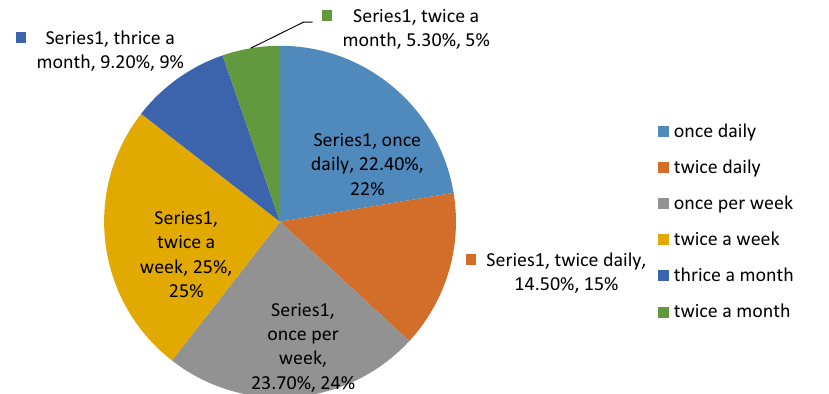
Figure 3: Frequency of potato crisps consumption by respondents.